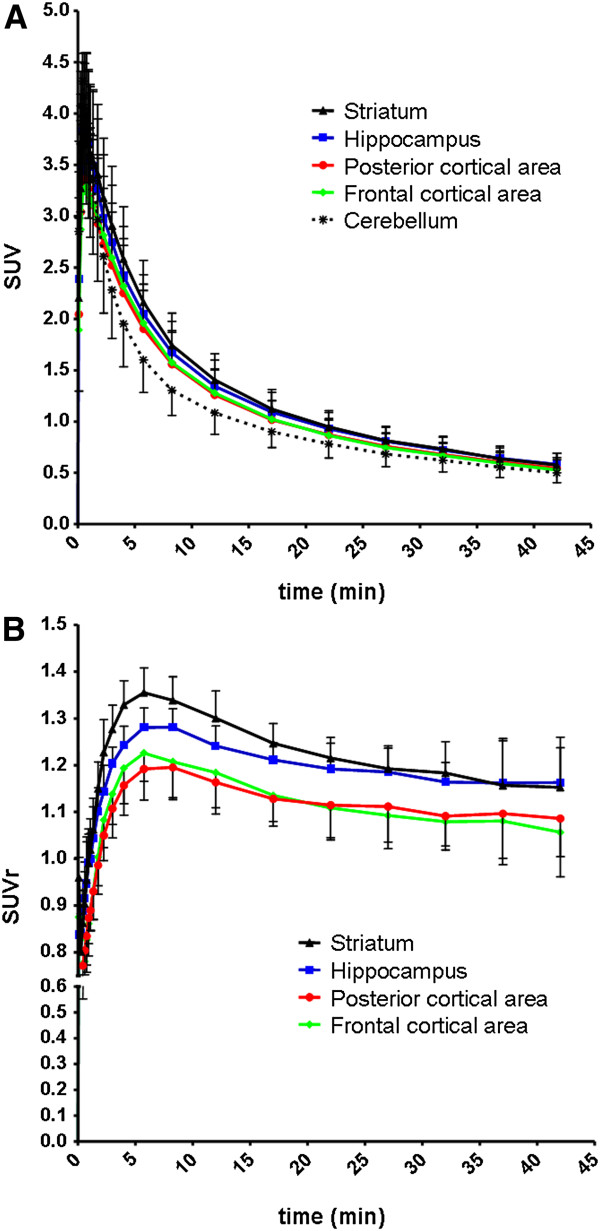
Standard uptake values of [11C]AF150(S) in various brain regions obtained from PET experiments. (A) Regional brain concentration, expressed as SUV, as a function of time following IV injection of [11C]AF150(S) and (B) relative to cerebellar concentration (SUVr). Each data point represents the mean of 44 animals. Vertical lines indicate the SD.